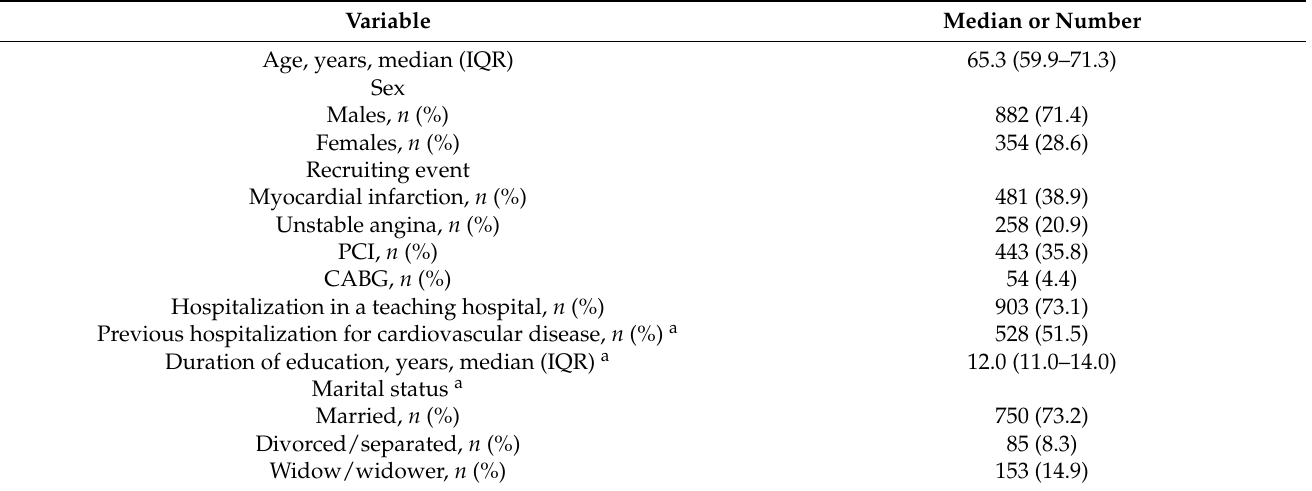
Table 1. Characteristics of the study